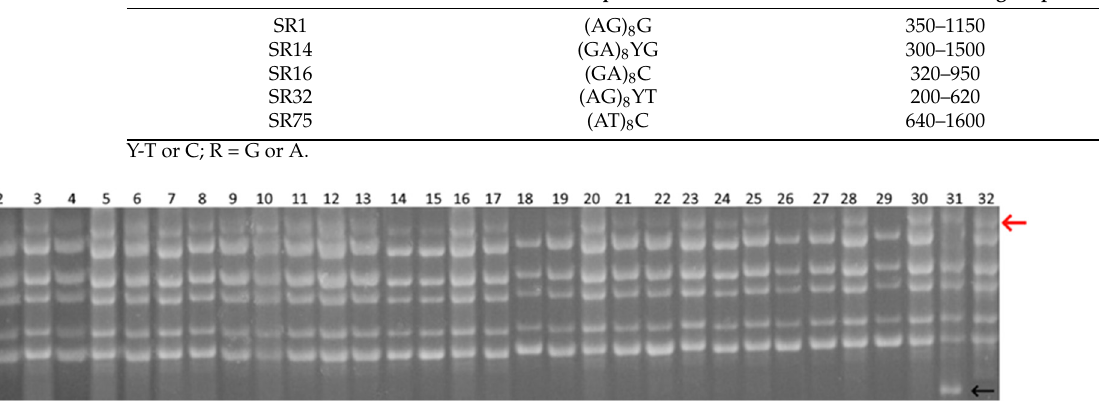
Table 6. ISSR primers used in S. myrtilloides analysis.